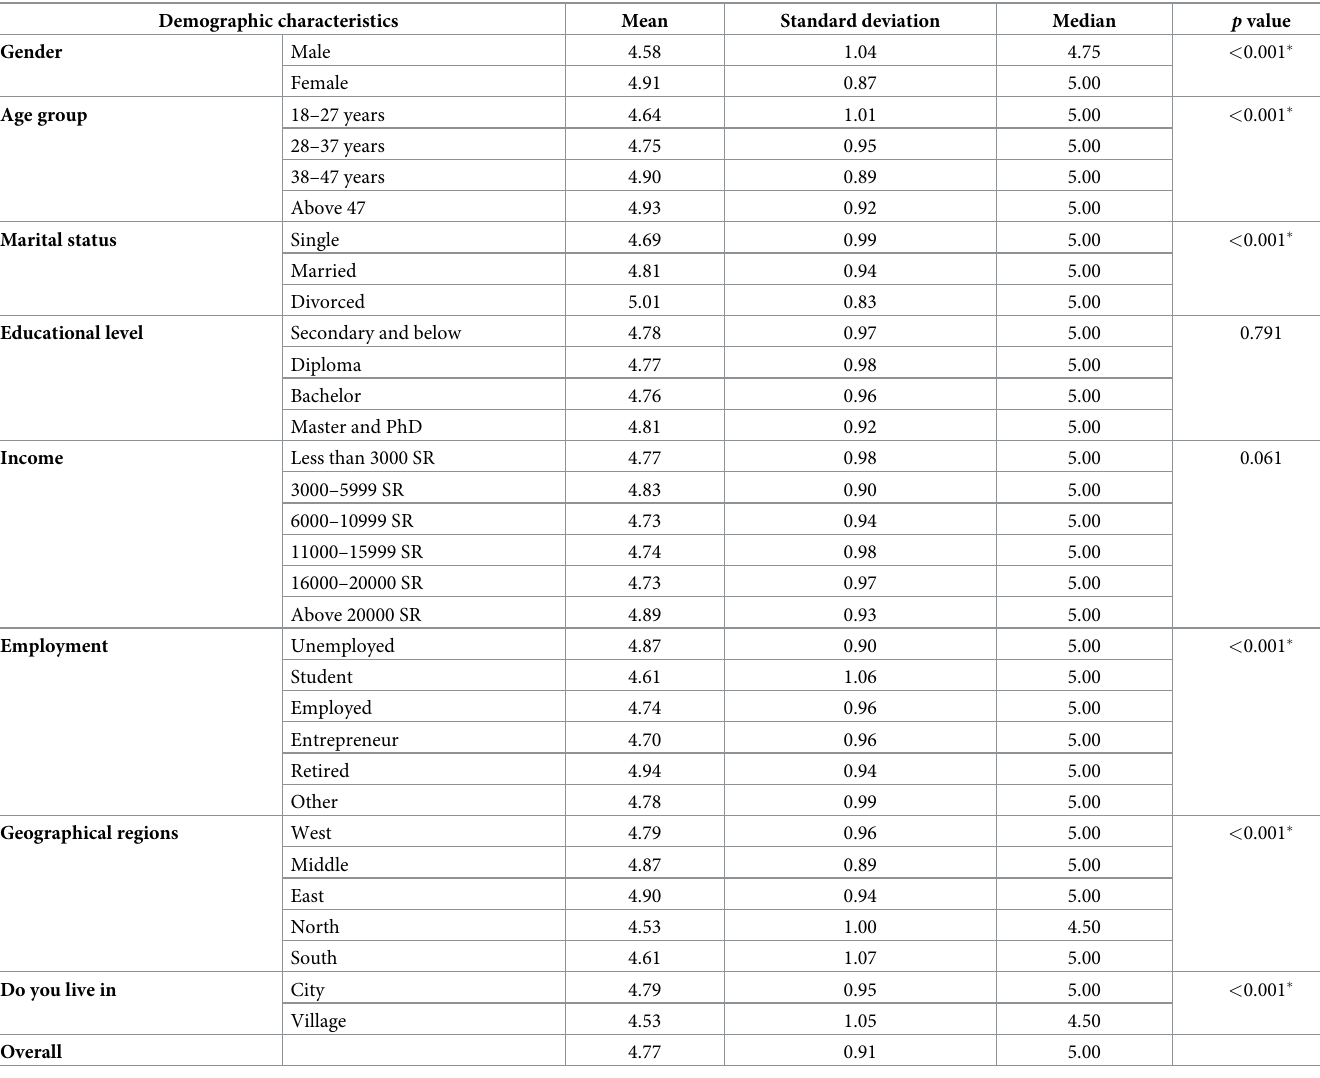
Table 5. Total scores of responses for questions in relation to hand hygiene and wearing gloves/masks when leaving the home during the COVID-19 pandemic. Demographic